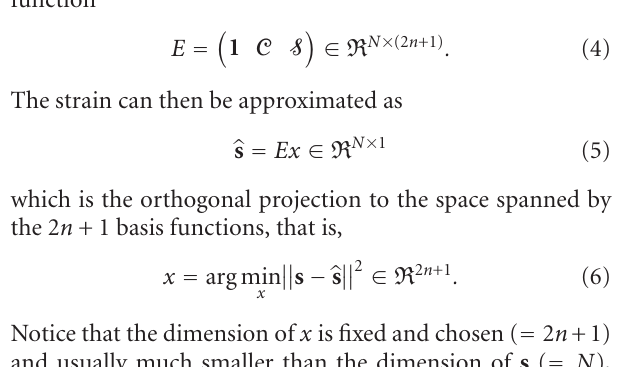
Figure 2: AFO strain signal output and extraction of strain signal for one gait cycle (red ( ∗ )). Thresholds γ 1 , γ 2 for finding the auxiliary times t aux (first t when S ( t ) < γ 1 ) and t start (first t when S ( t ) > γ 2 ) are